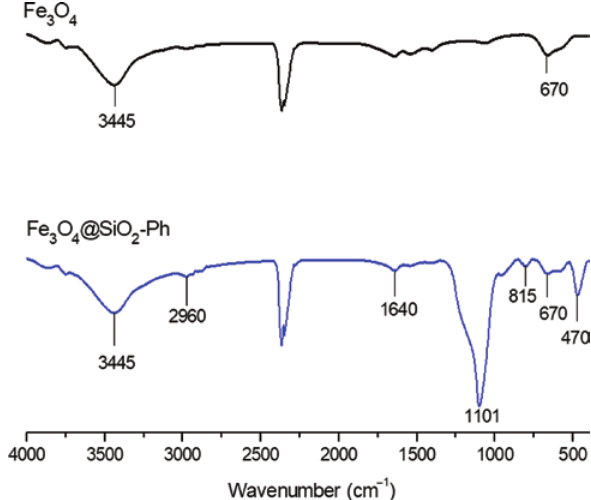
O and Fe O @SiO -Ph (prepared 3 4 3 4 2